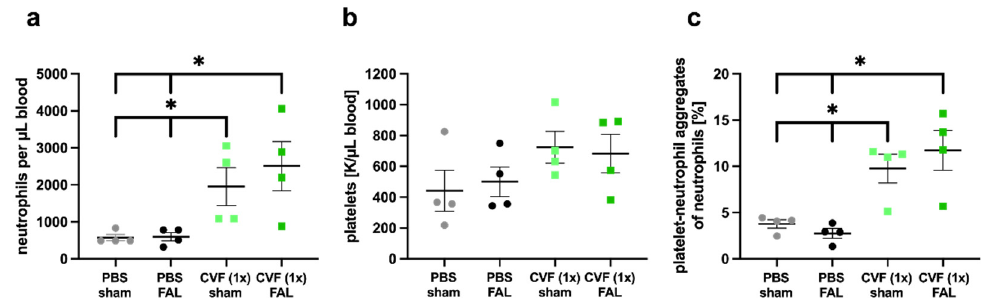
Figure 4. Single-dose application of the cobra venom factor (CVF (1x)) enhances the formation of platelet-neutrophil aggregates (PNAs) and the mobilization of neutrophils to the peripheral blood. Scatter plots show flow cytometry analyses of ( a ) the number of neutrophils per microliter of blood, ( b ) the number of platelets per microliter of blood measured by the differential blood count, and ( c ) the percentage of PNA formation relative to the total number of neutrophils in phosphate-buffered saline (PBS)- and CVF (1x)-treated mice 27 h after injection, respectively, 3 h after double femoral artery ligation (FAL) or a double sham operation (sham) of both femoral arteries. For the PNA analysis, platelets were detected by an anti-CD41 antibody, and neutrophils were identified by anti-CD11b and anti-Gr-1 antibodies. All values are the means ± S.E.M., n = 4 mice per group, * p < 0.05 by one-way analysis of variance (ANOVA) with Tukey’s multiple comparison